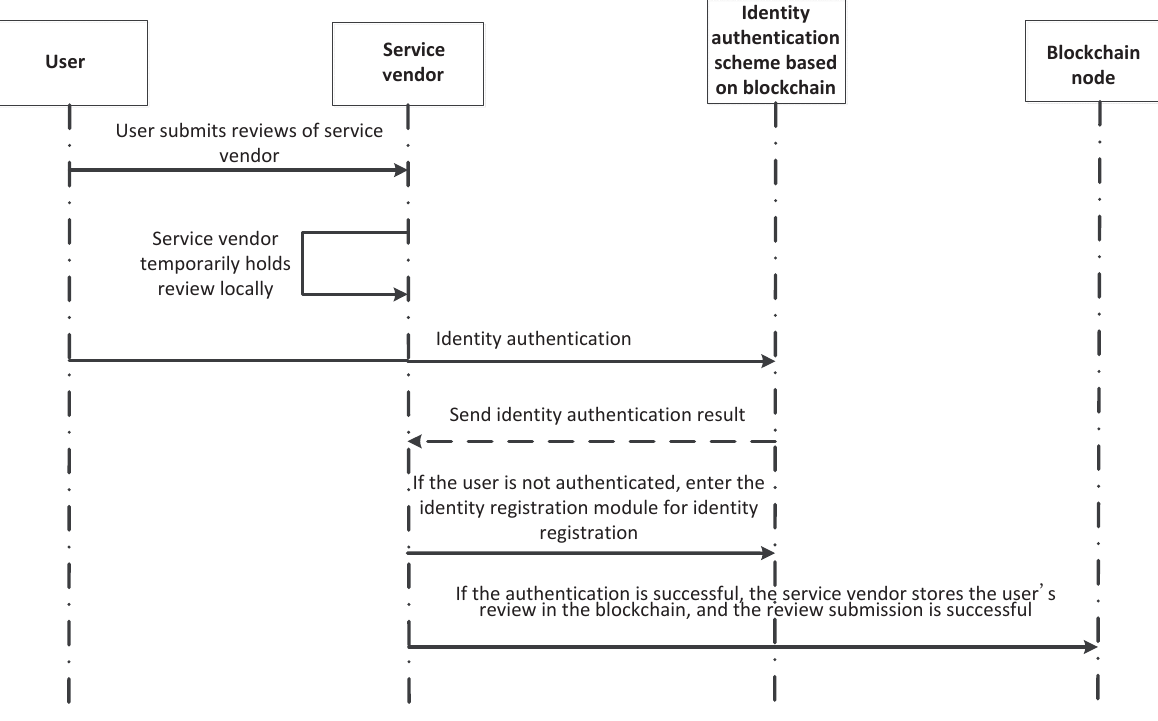
Fig. 6 Workflow of the review submission module.